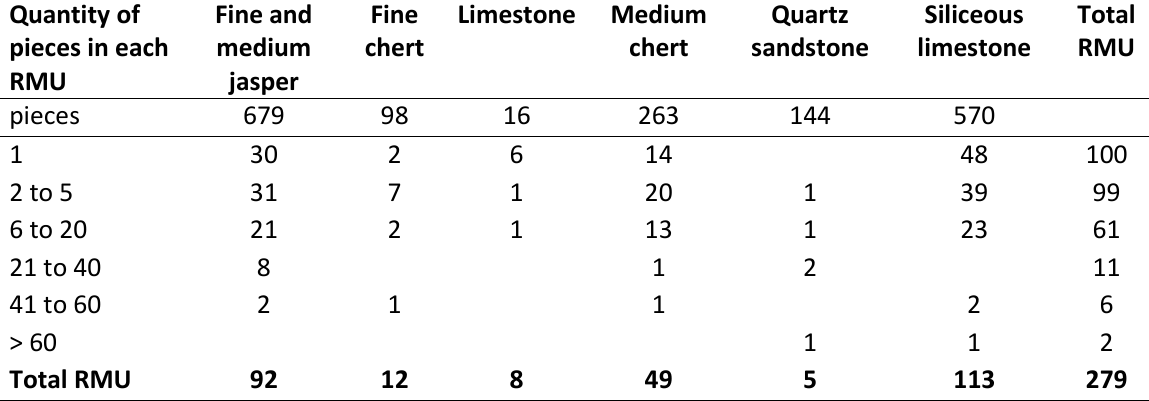
Table 6: Quantity of pieces in each RMU, and amount of pieces and RMU for each raw material. Quantity